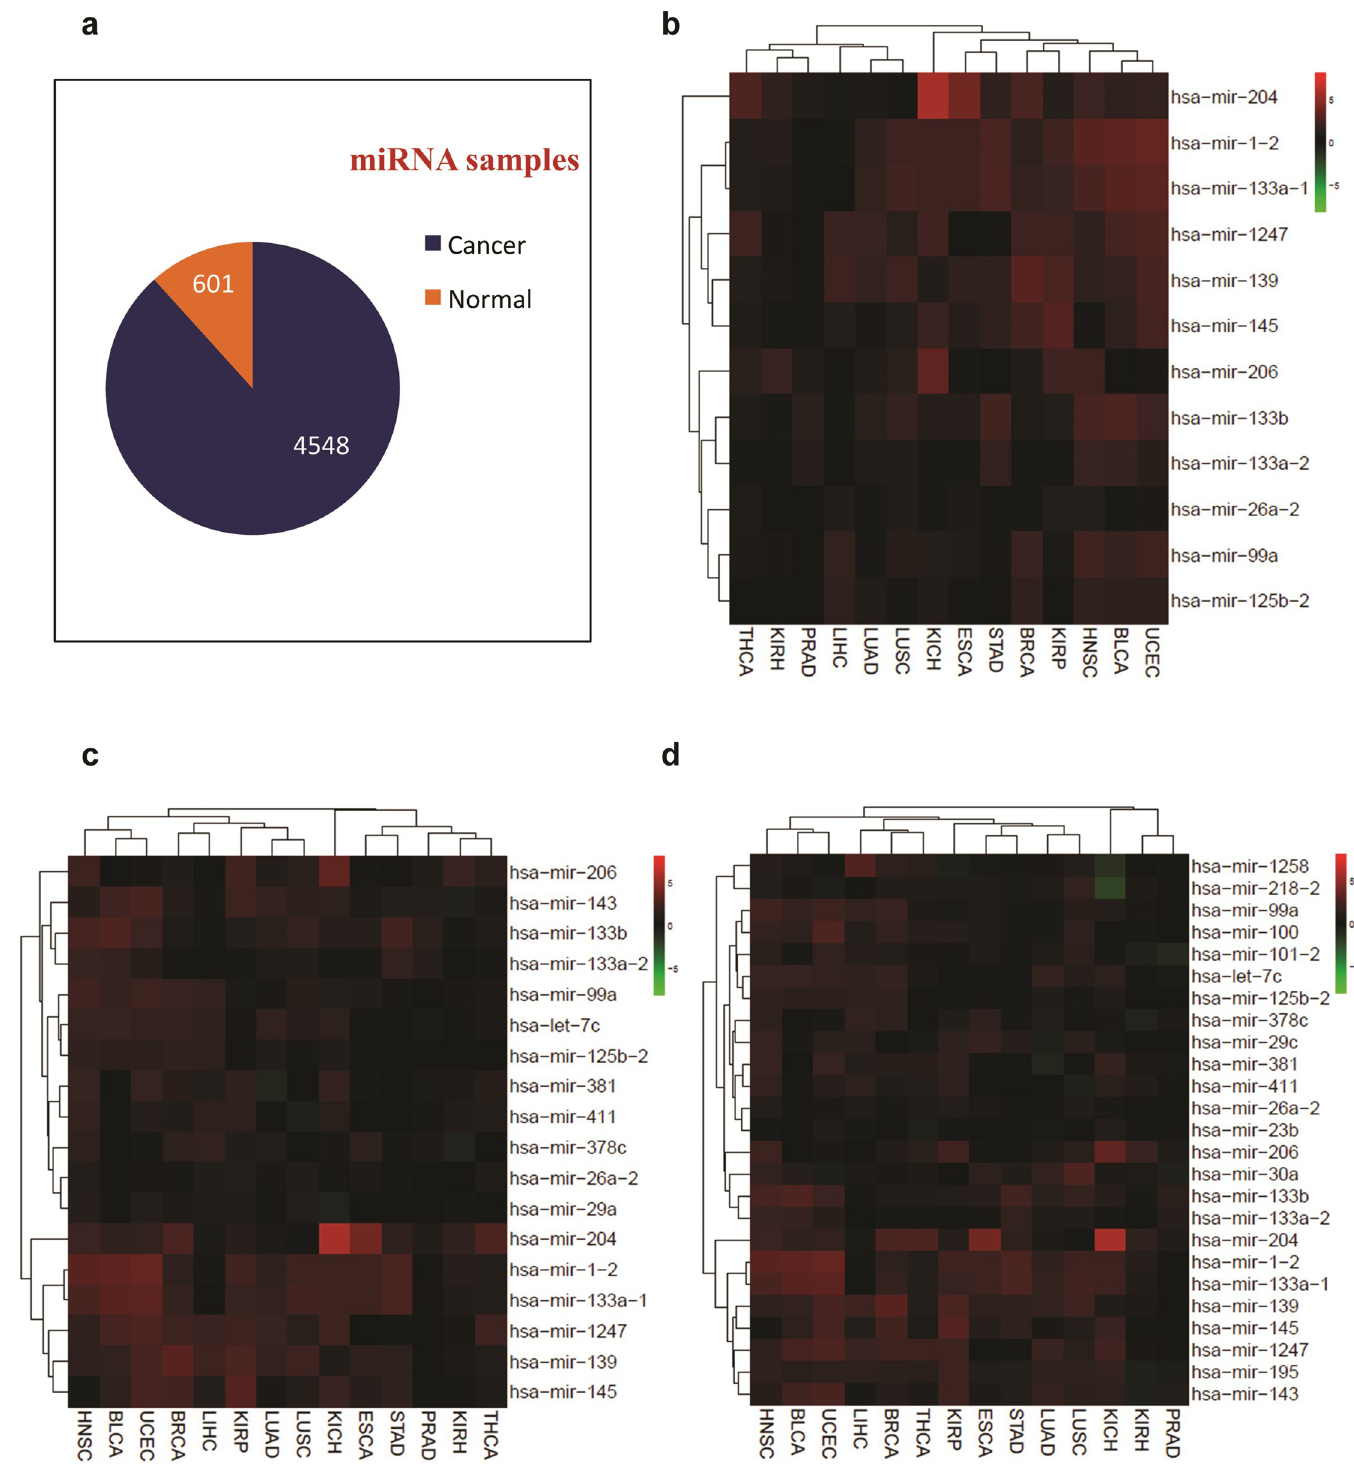
Fig 1. Identification of pan-cancer normomiRs. ( a ). The total number of global miRNA expression profiles from normal and tumor cells. ( b ). Heatmap of miRNAs showing higher expression in 14 out of 14 normal tissue types than corresponding tumor cells. ( c ). The miRNAs showing higher expression in 13 out of 14 normal tissue types than corresponding tumor cells. ( d ). The miRNAs with higher expression in 12 out of 14 normal tissue types than corresponding cancer cell types.